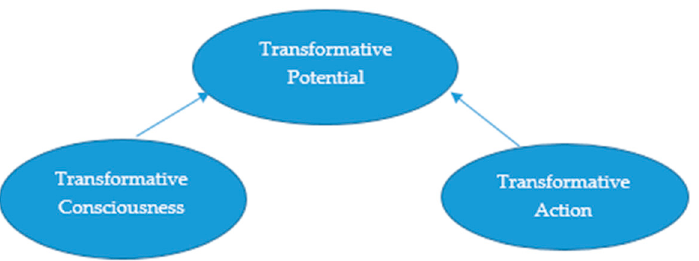
Figure 1. The Transformative Potential Model. Note. Figure 1 depicts the two dimensions of Transformative Potential (Jemal 2018).